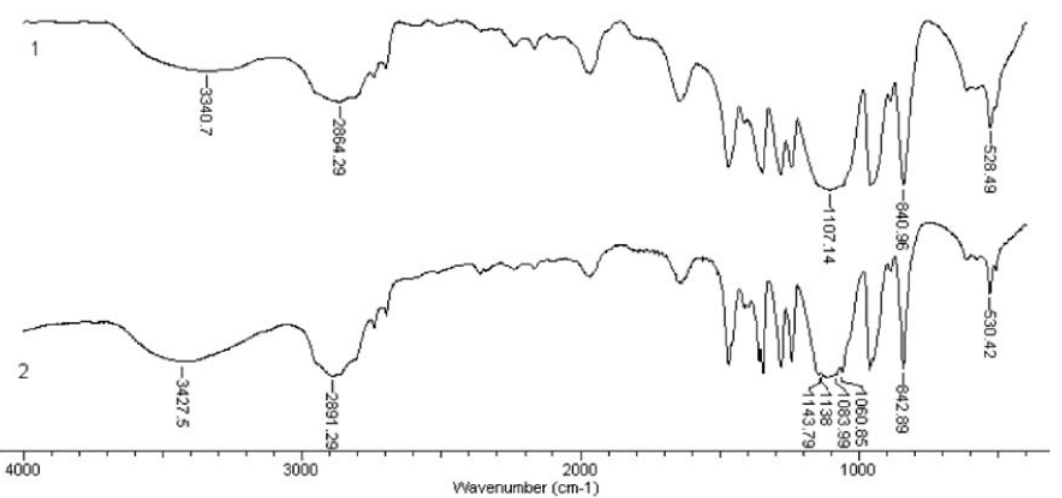
Fig. 6 IR spectra of solid PEG-rich extract without (1) and with Cd(II) plus iodide (2), extractant pH = 7.12. (Cd i = 57.05 µ g/mL, [I − ] add = 0.06 mol/L).